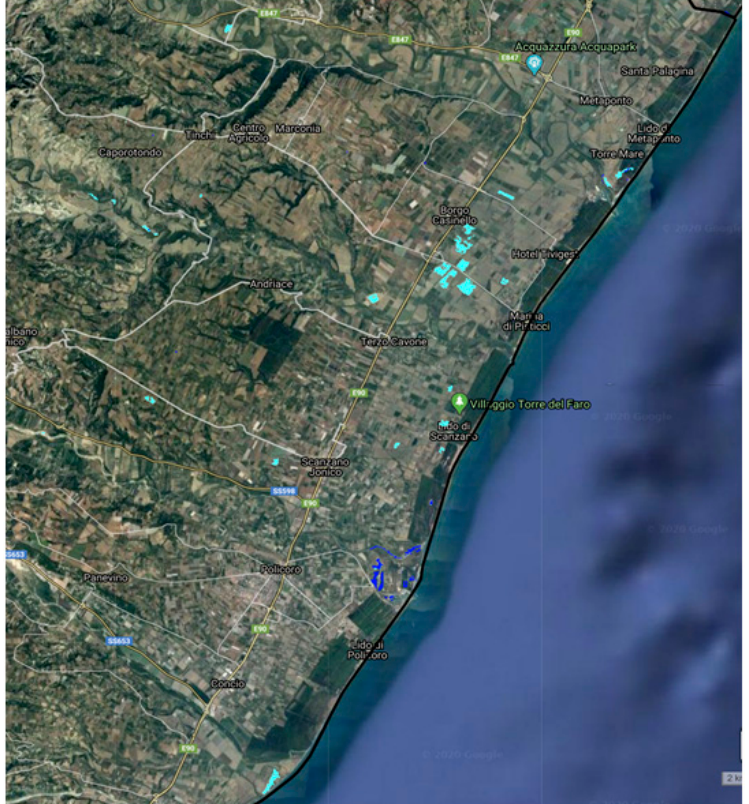
Figure 8. Flooding areas as indicated by the light blue pixels occurred in November 2019. The image was extracted from the Sentinel S1B satellite. Source: Centro funzionale centrale Basilicata.